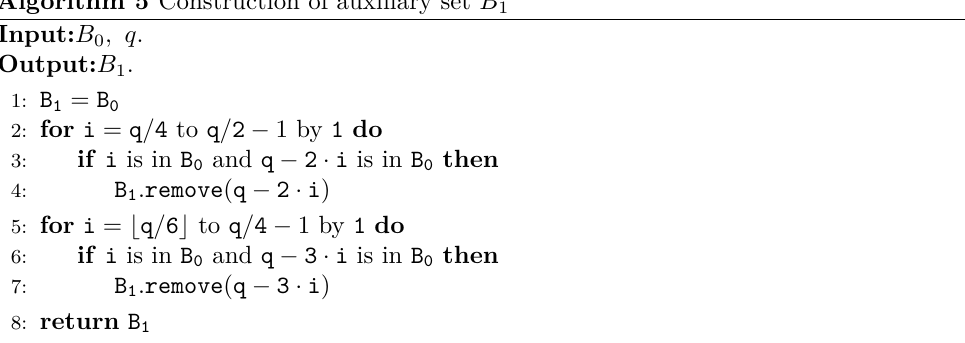
Algorithm 5 Construction of auxiliary set B 1